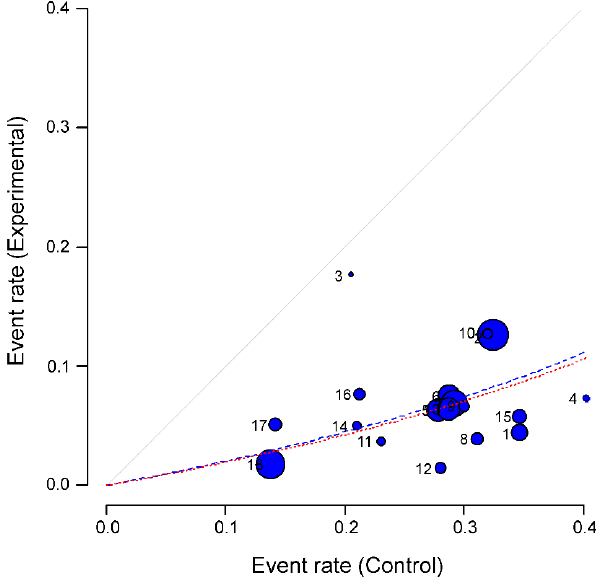
Figure 4. Heterogeneity of the studies in the meta-analysis: L’Abbé graph [47]. All 18 studies selected in the systematic review are plotted, numbered from 1 to 18 (correspondence between numbers and studies can be found above, Tables 1 and 2, second column). The graph represents the response rates to the experimental event (current smoking) versus the response rates in the control group (hospitalization). Studies are plotted with an area proportional to its accuracy (blue circles), and its dispersion indicates heterogeneity. Dashed lines represent the pooled effect of the meta-analysis (red for fixed effect model and blue for random effect model).